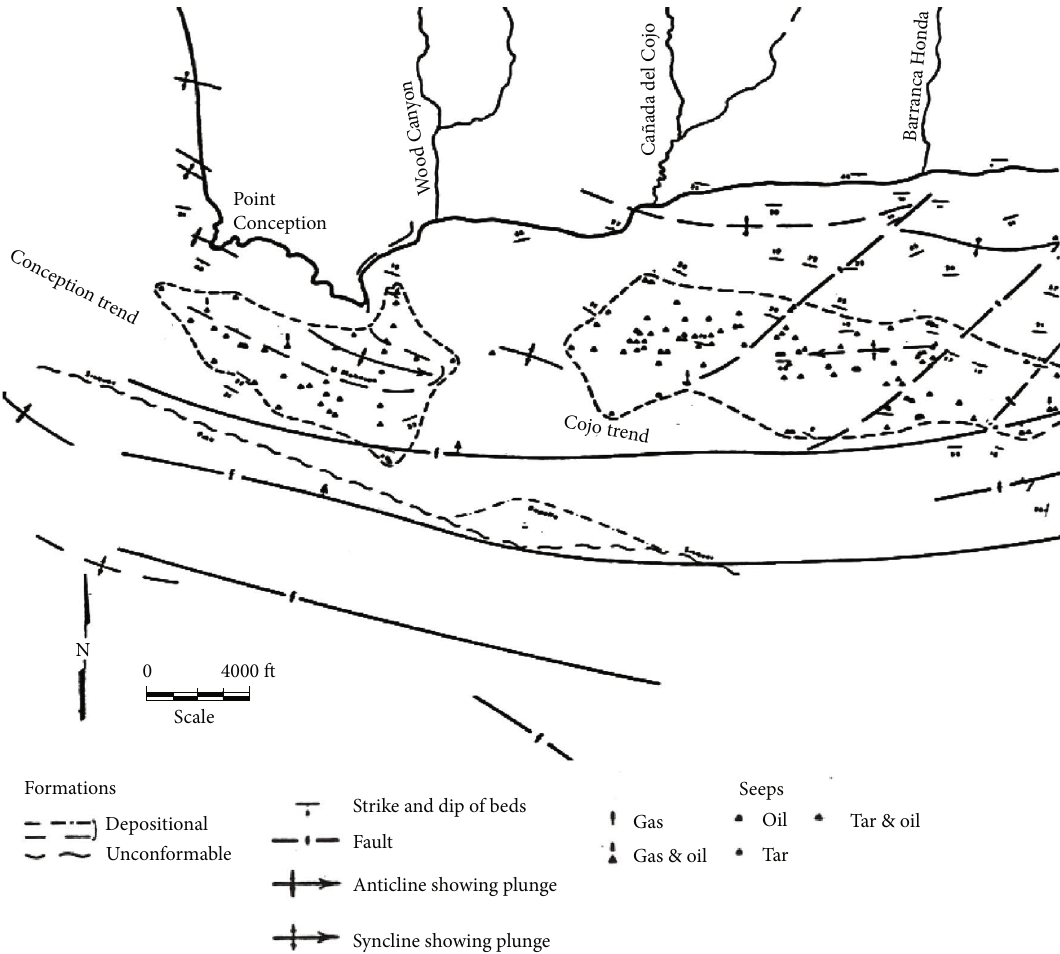
Figure 13: Geology and gas and oil seepage o ff Point Conception. Legend on the fi gure. Adapted from Fischer ([50], Fig.